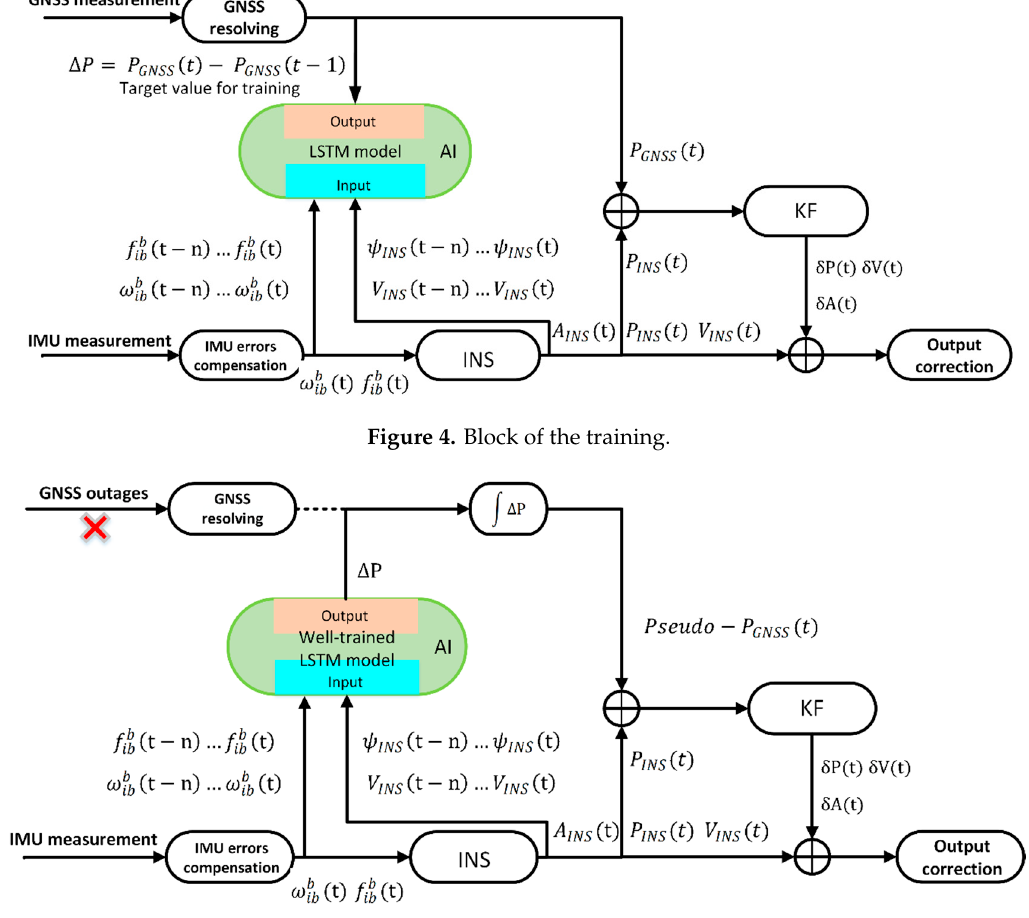
Figure 5. Block of the predicting.